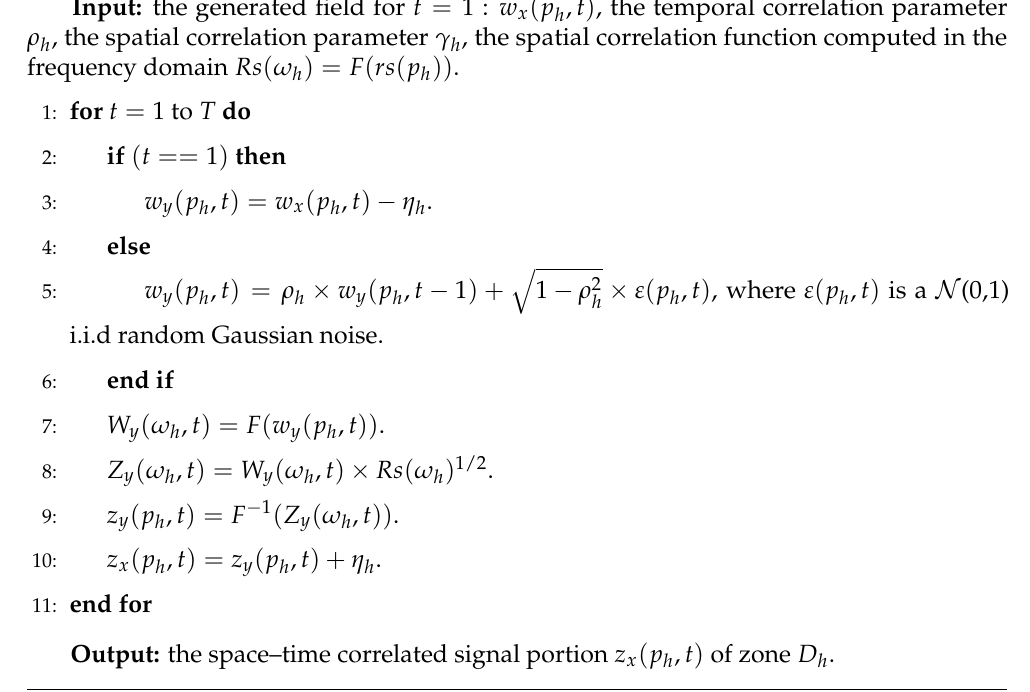
Algorithm 1 Model for generating a portion of the